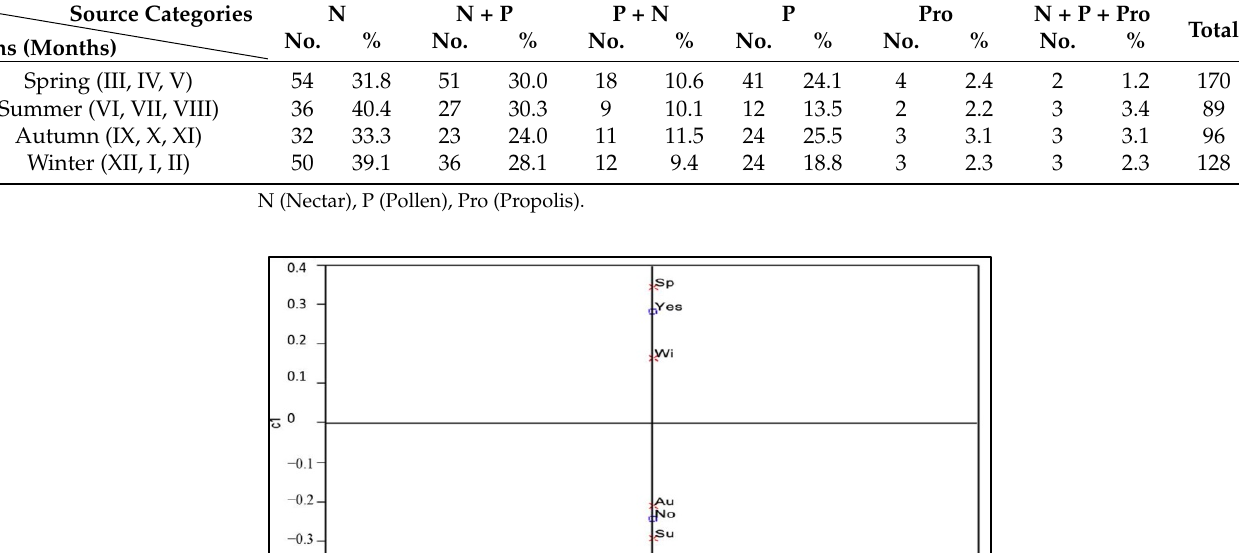
Table 3. Nectar and Pollen flow during different seasons in Al-Baha region, Southwestern Saudi Arabia.